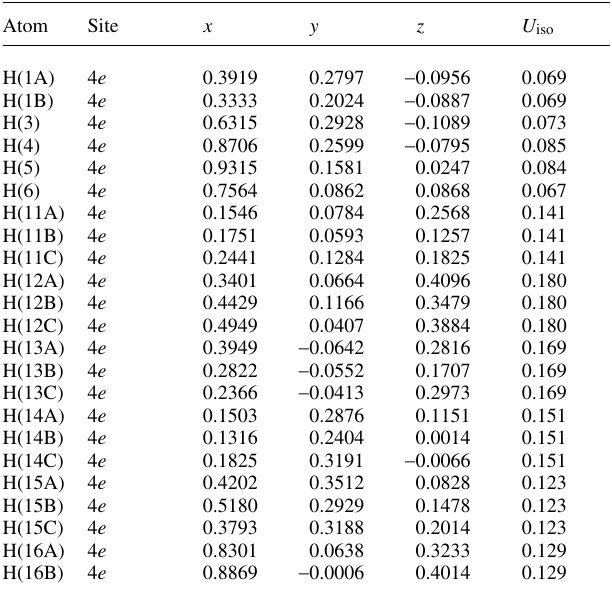
Table 2. Atomic coordinates and displacement parameters (in Å 2 )